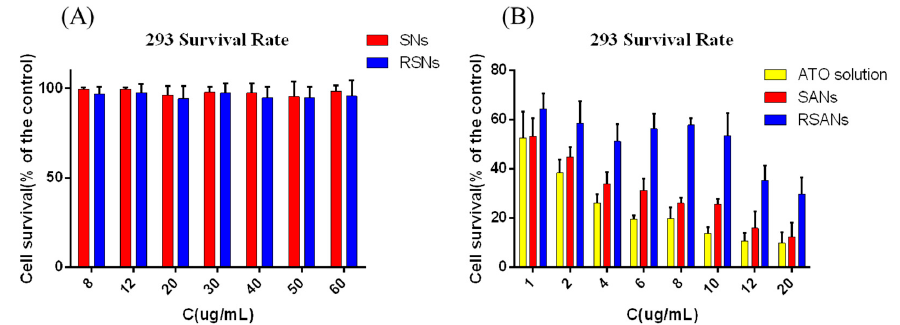
Figure 8. Cell survival of 293 cells after administration with different concentrations of ( A ) SNs and RSNs, ( B ) ATO, SANs and RSANs for 24 h. Data are shown as ± SD of the mean ( n = 3).